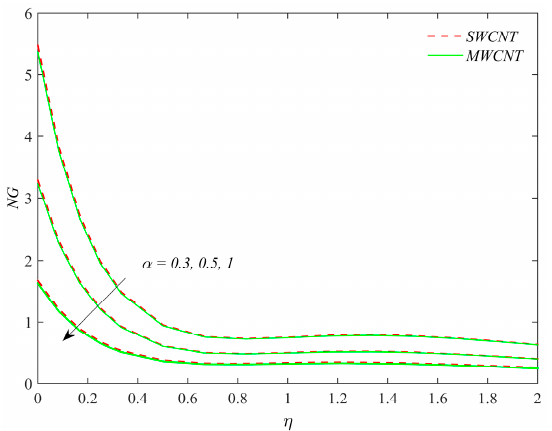
the similarity variable for the distinct values of the diffusive constant parameter λ .